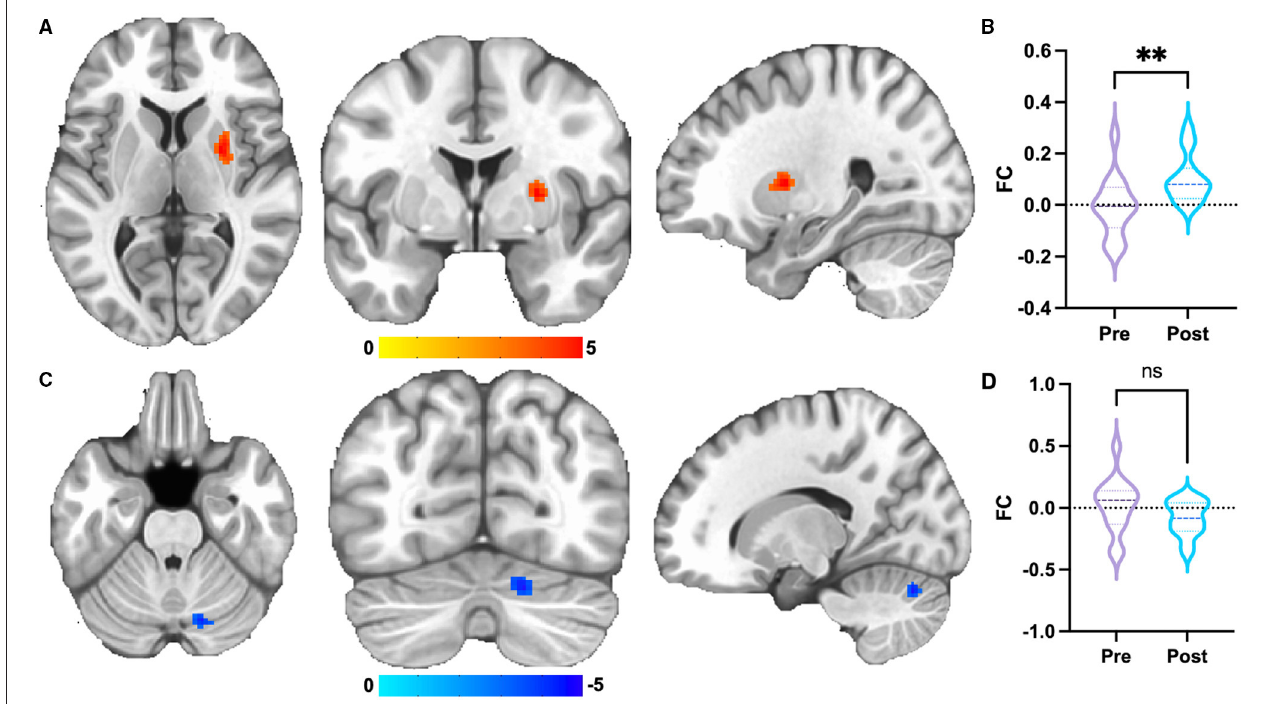
FIGURE 2 | Group differences of FC. (A) FC of dorsal RPN of patients with KOA enhanced at post-acupuncture compared with HC. The result was corrected for FDR with p < 0.001. (B) FC differences of right putamen between pre-acupuncture and post-acupuncture in KOA. (C) FC of medial RPN of patients with KOA decreased at post-acupuncture compared with HC. The result was uncorrected with p < 0.001. (D) FC differences of right cerebellum between pre-acupuncture and post-acupuncture in KOA. **: represents significant group difference with p < 0.05; ns: represents no significant group difference.